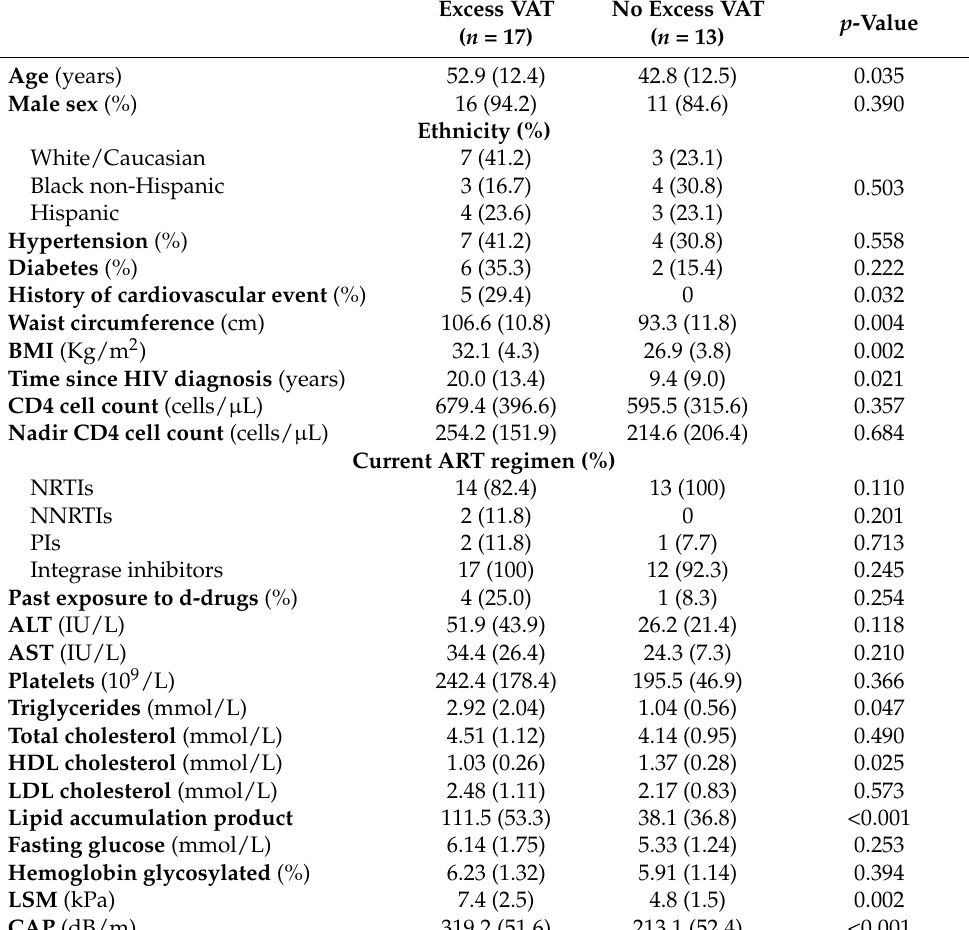
Table 1. Characteristics of the study population by excess VAT status ( n =